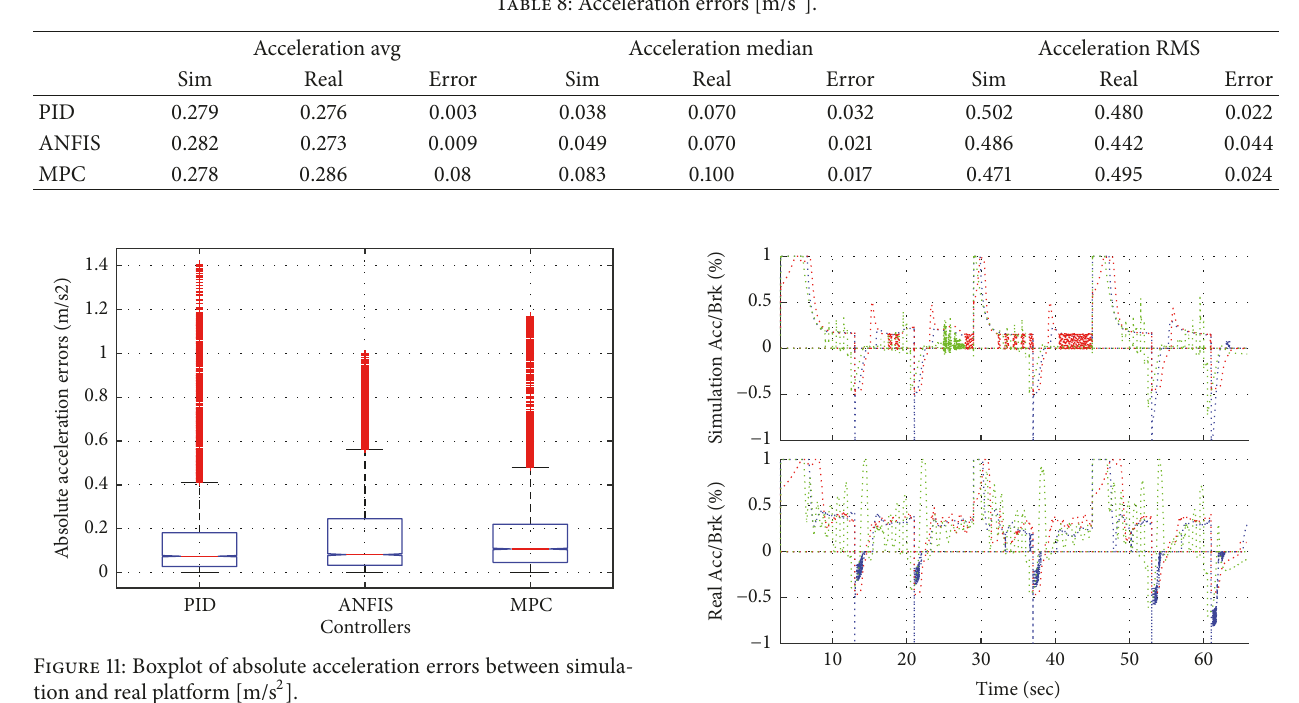
Table 8: Acceleration errors [m/s 2 ].